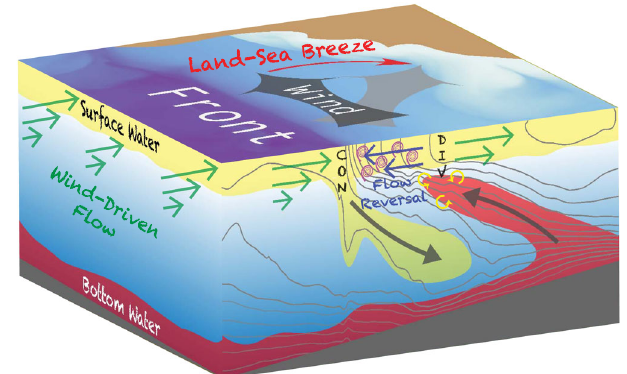
Fig. 6 | Schematic ofthe keyprocessescontributing to theverticalcirculation. A diurnal land-sea breeze generates an inertially-oscillating wind-driven surface fl ow.Thewind-driven fl owinteractswithanoceanfrontandtransportsdensewater over light water at certain phases over an inertial cycle, destabilizing the water column and enhancing turbulence and mixing at the front. The mixing of the geostrophic fl ow by the turbulence creates a counter fl ow at the front, which runs opposite to the wind-driven fl ow and leads to strong convergence (abbreviated as CON). Similarly, the fl ow reversal also leads to divergence (abbreviated as DIV) at the light side of the front. The near-surface convergence and divergence at the front set up a slantwise circulation along isopycnals in the interior, inducing downwelling of surface water and upwelling of bottom water. This vertical exchange can insert lower dissolved oxygen waters into the surface mixed layer, where oxygenation can be stimulated by mixing processes (schematized by the yellow curly